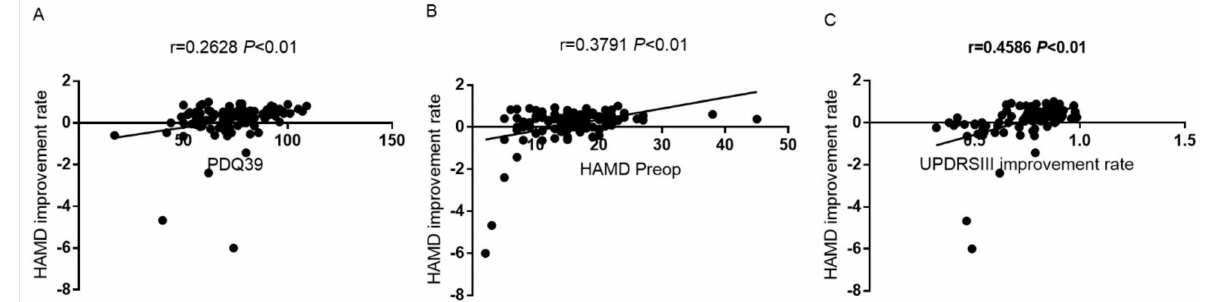
Figure A1. Correlations of HAMD score improvement rate with PDQ − 39 ( A ), HAMD Preop ( B ) and UPDRSIII improvement rate ( C ).